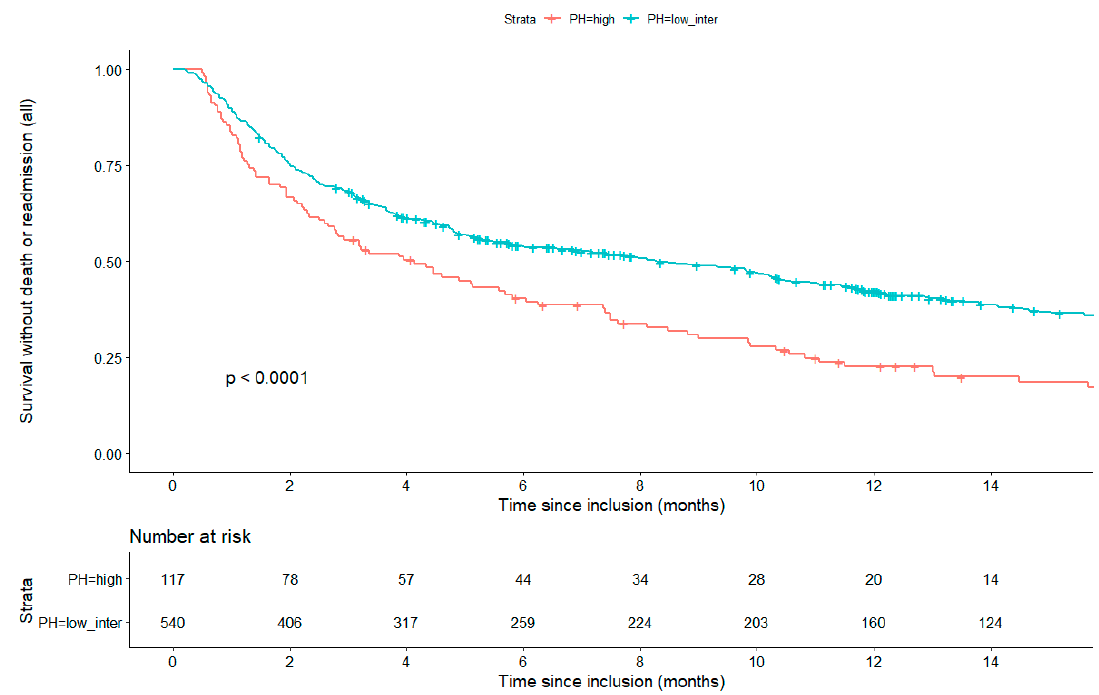
Figure 1. Kaplan–Meier survival analysis for the primary outcome of all-cause mortality and readmission in patients with a high versus a low or intermediate probability of pulmonary hypertension (PH).